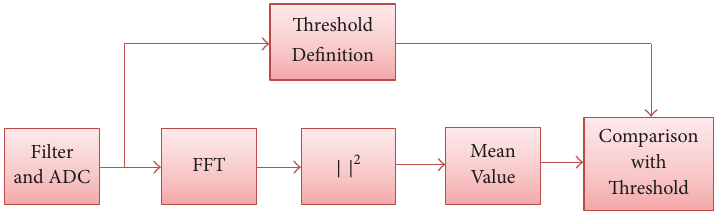
Figure 4: Block diagram of energy based spectrum sensing.